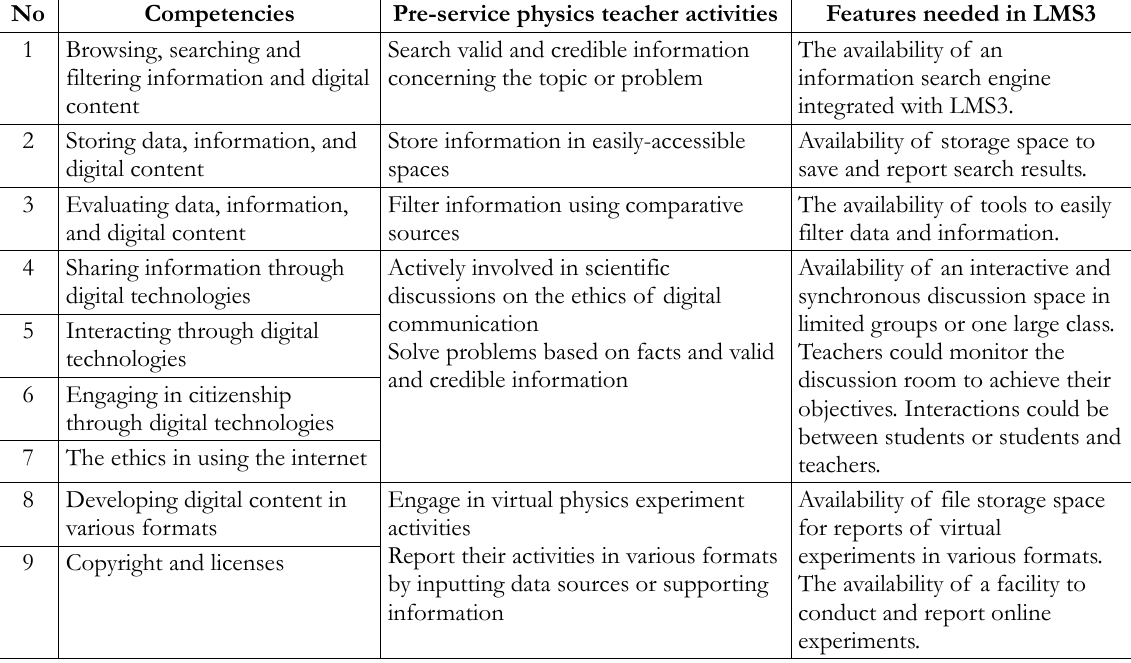
Table 3. Need Analysis of LMS3 in Physics for School